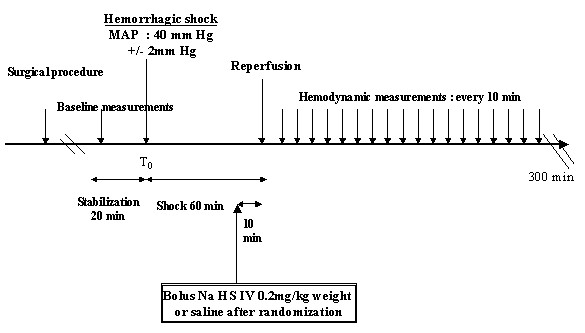
Design of the protocol (in case of hemorrhagic shock).